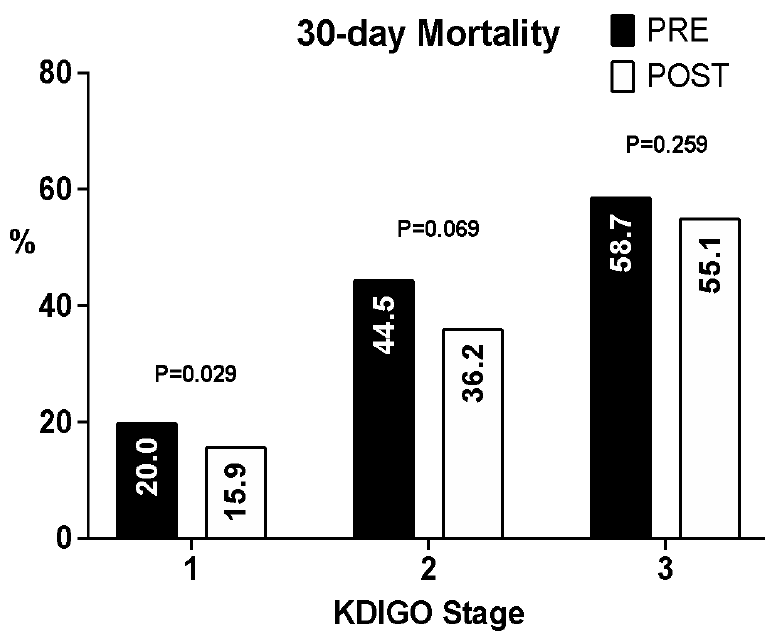
Figure 3. Acute kidney injury 30-day mortality according to the KDIGO stage. The analysis of independent predictive factors for 30-day mortality indicated that older age and ICU admission were associated with a higher risk of 30-day mortality. Other predictive factors were baseline eGFR, pulmonary disease, and malignancy. The AKI electronic alert in patients’ EMR was an independent predictive factor for 30-day mortality (Table 4). Table 4. Cox univariate and multivariate proportional hazard models: 30-day mortality.